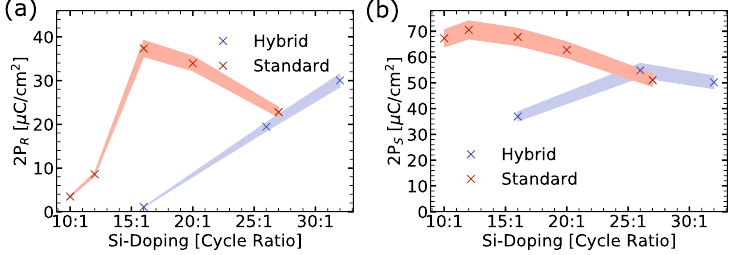
Figure 4. Remanent and saturated polarization (P R and P S ) of hybrid and standard HSO samples. P R ( a ) starts increasing at lower number of Hf cycles in case of standard HSO compared to hybrid HSO. Much lower P S values ( b ) are observed for the hybrid HSO 16:1 cycling